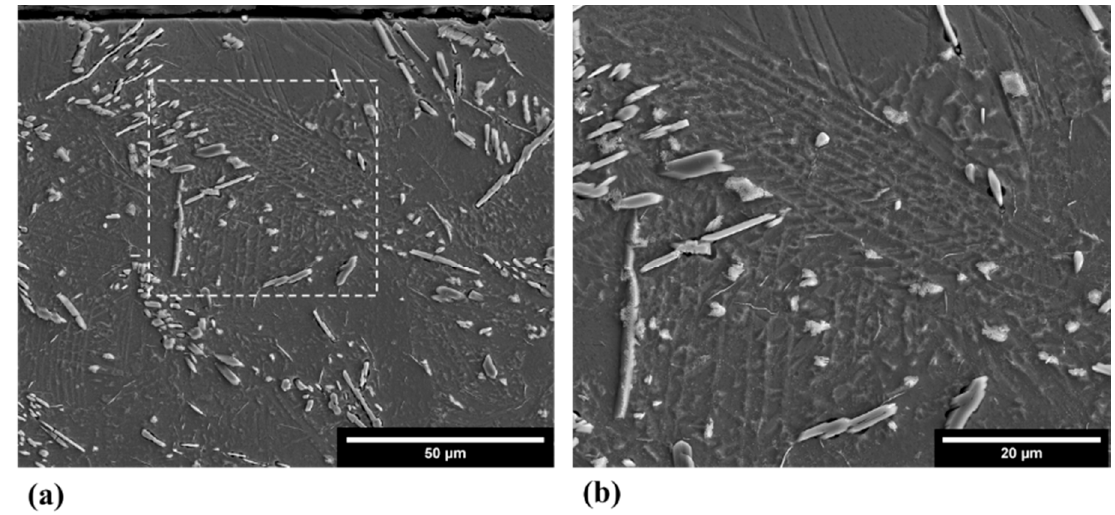
Figure 9. SE-SEM image showing ( a ) the typical subsurface cross-section microstructure of a PTA-SFFF Ti–TiB coupon subjected to shot peening and polishing treatment, as described in Section 3.3, etched in Kroll’s etchant. ( b ) The higher magnification image from the enclosed box region showing microstructural hatched features due to shot peening.